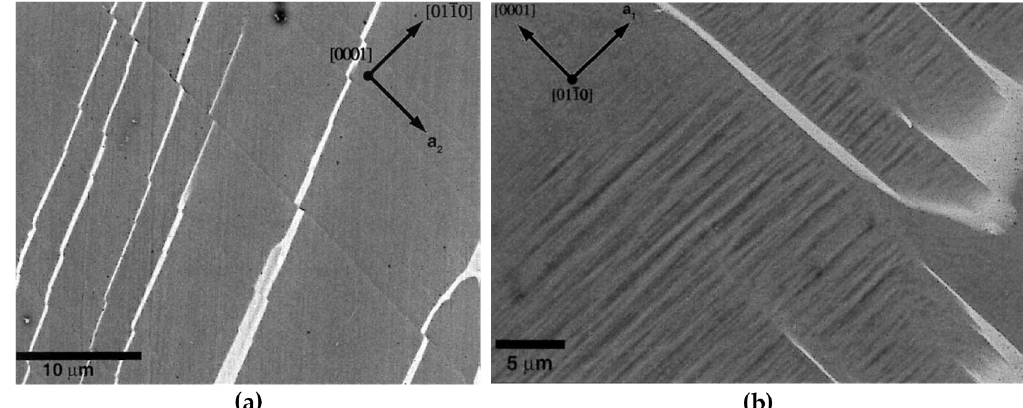
Figure 22. SEM images of interaction between slip and lamellar interfaces. ( a ) The prism slip; ( b ) The basal slip. (Reprinted from Reference [49], with permission from Elsevier).